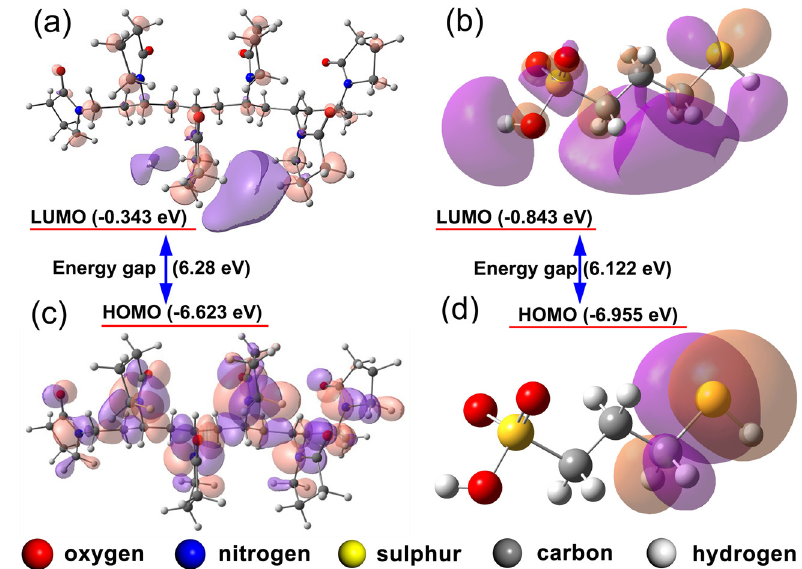
Figure 3: The simulated LUMO of PVP ( a ) and MPS ( b ) . The simulated HOMO of PVP ( c ) and MPS ( d ) .